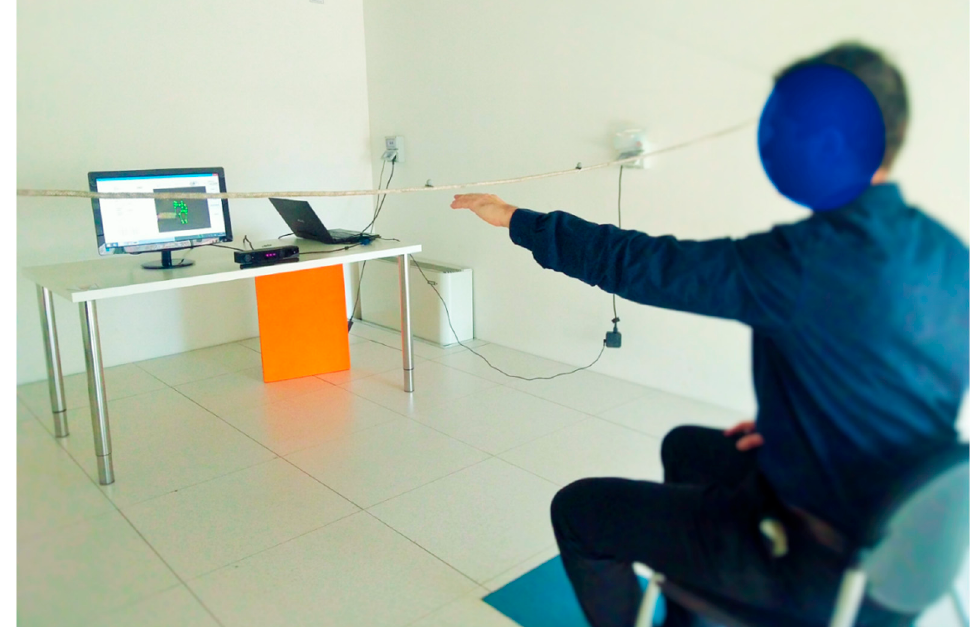
Figure 1. The set-up for Kinect recordings, portrayed in the movement analysis room in Consiglio Nazionale delle Ricerche (CNR), Systems and Technologies for Advanced Manufacturing (STIIMA) Lecco, replicated in CNR – STIIMA Milano, and in the Villa Beretta Rehabilitation Hospital.